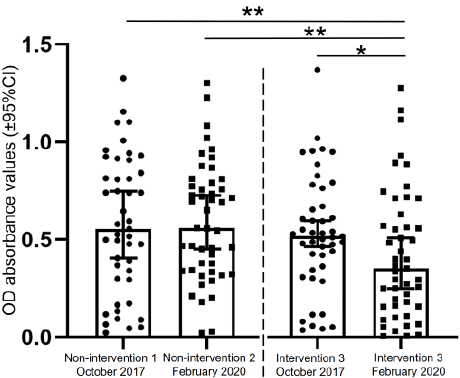
Figure 6. The comparison of the median OD absorbance values obtained using the NS1 ELISA for serum samples collected in October 2017 (pre-intervention) or February 2020 (post-intervention) at the non-intervention or intervention sites. p -values were calculated using the Mann-Whitney U test (pre-intervention vs. post-intervention: * p < 0.05 and ** p < 0.01). OD: optical density.